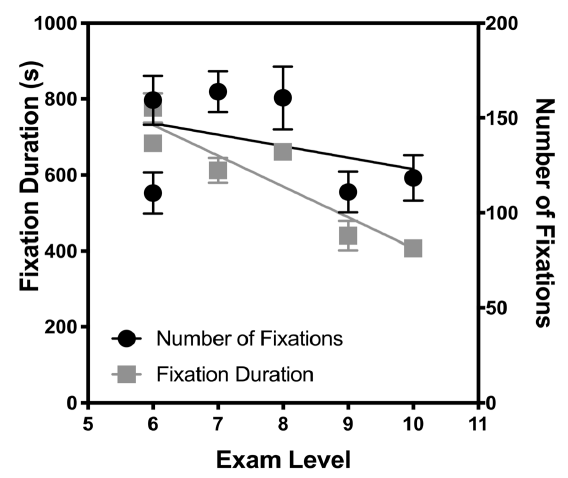
Figure 4. Eye movement versus level of exam